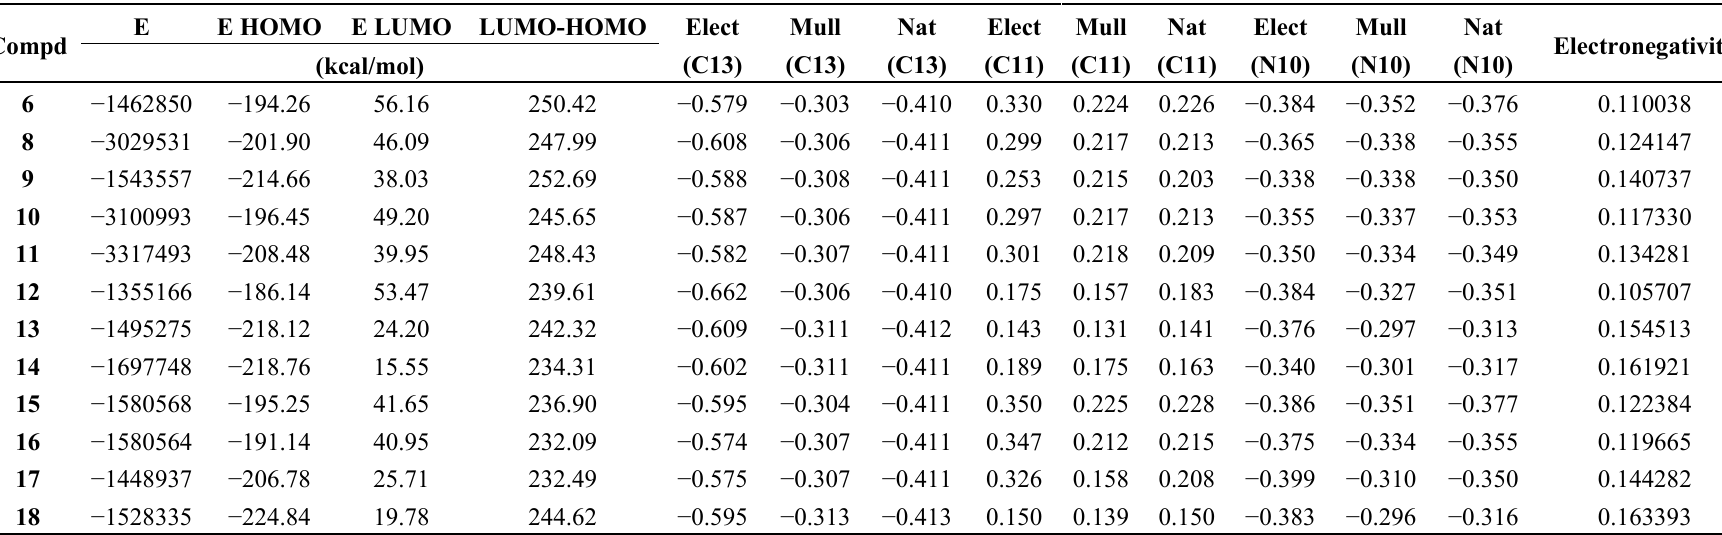
Table 3. Theoretical molecular parameters of compounds 6 , 8 ‒ 18 : E, E HOMO, E LUMO, Elect (i), Mull (i), Nat (i),